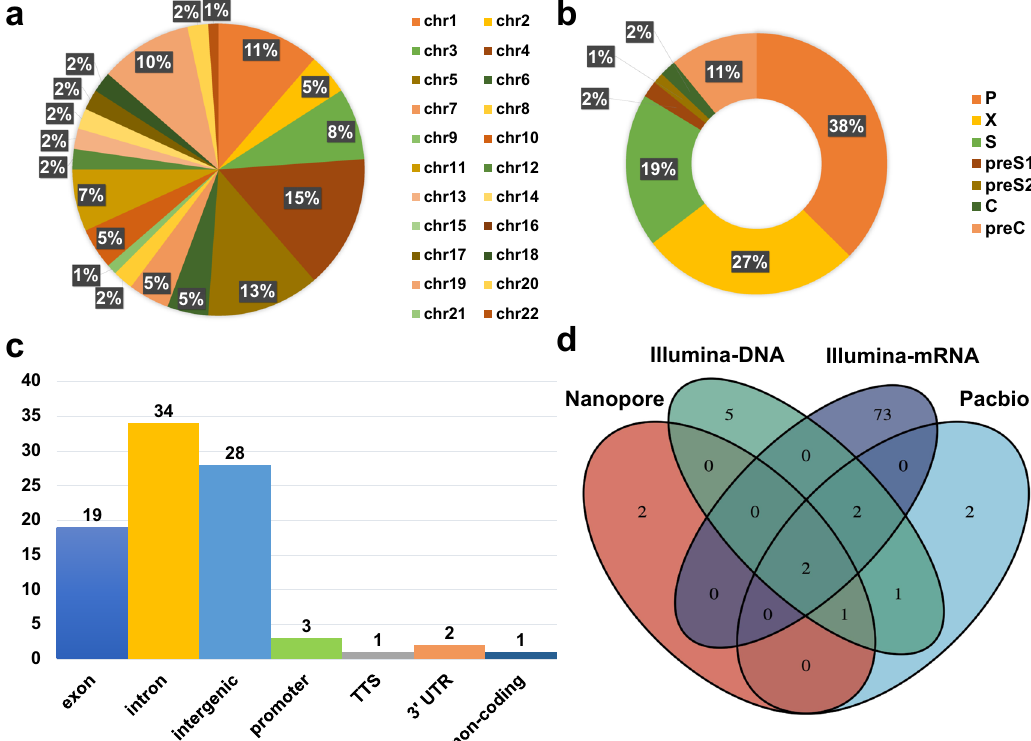
Fig. 3 Distribution of integration breakpoints in human and HBV genome. a HBV integration breakpoints distribution in human chromosomes, different colors represent different chromosomes. b HBV integration breakpoints distribution in the HBV genome, different colors represent different genes of HBV. c HBV integration breakpoints functional locations in the human genome, different colors represent different regions of HBV. d overlap HBV integration breakpoints of four sequences, different colors represent different platforms of